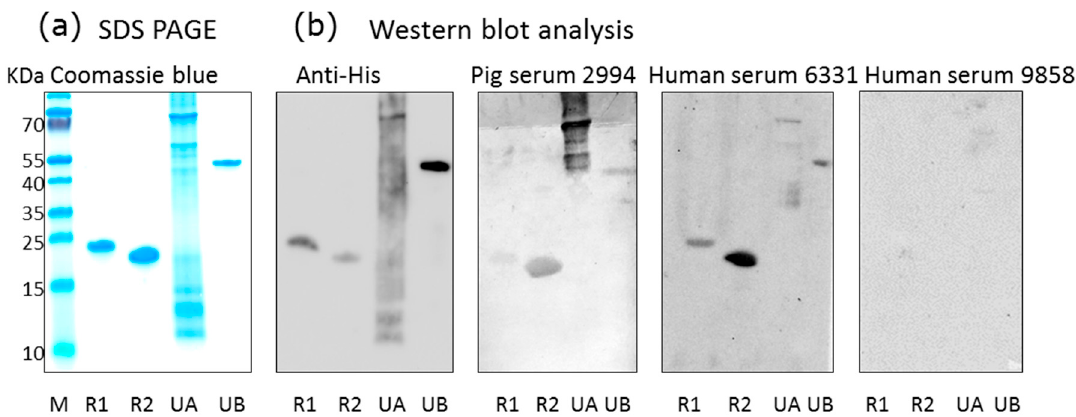
Figure 1. Western blot analysis of human and pig sera using porcine cytomegalovirus (PCMV) proteins as antigens. ( a ) SDS-PAGE and Coomassie blue staining of purified recombinant PCMV-derived proteins: R1, N-terminal part of gB, R2, C-terminal part of gB, UA, tegument protein U54A, UB, tegument protein U54B, M, marker proteins; ( b ) Western blot analysis using antibodies against the His-tag, pig serum 2994, human sera 6331 and 9858. Antibodies were used at the following dilutions: anti-His antibodies 1:1000, pig serum 2994 1:300, human sera 6331 and 9858 were used 1:300, anti-mouse serum 1:1000, anti-human serum 1:1000, and anti-pig serum 1:1000.